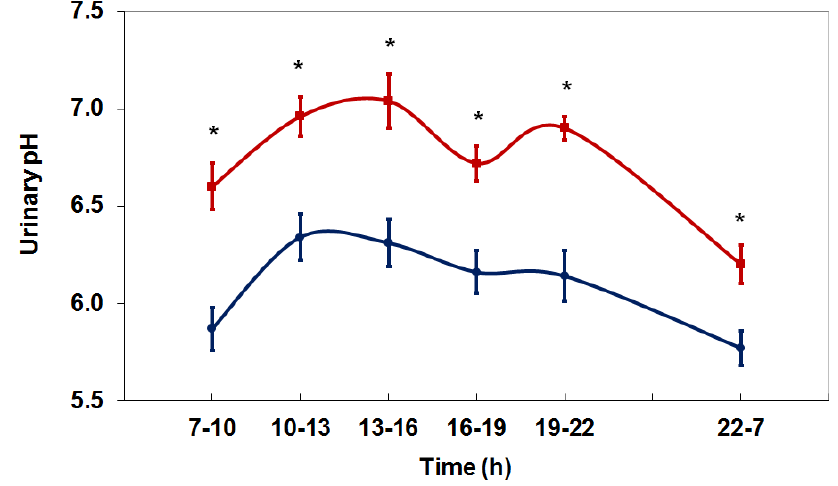
Figure 2. Diurnal variation in urinary pH during a 24-h period in healthy individuals under controlled, standardized conditions before (control, blue line) and after receiving bicarbonate-rich mineral water (red line) (M ± SEM) (* p < 0.05) [36].